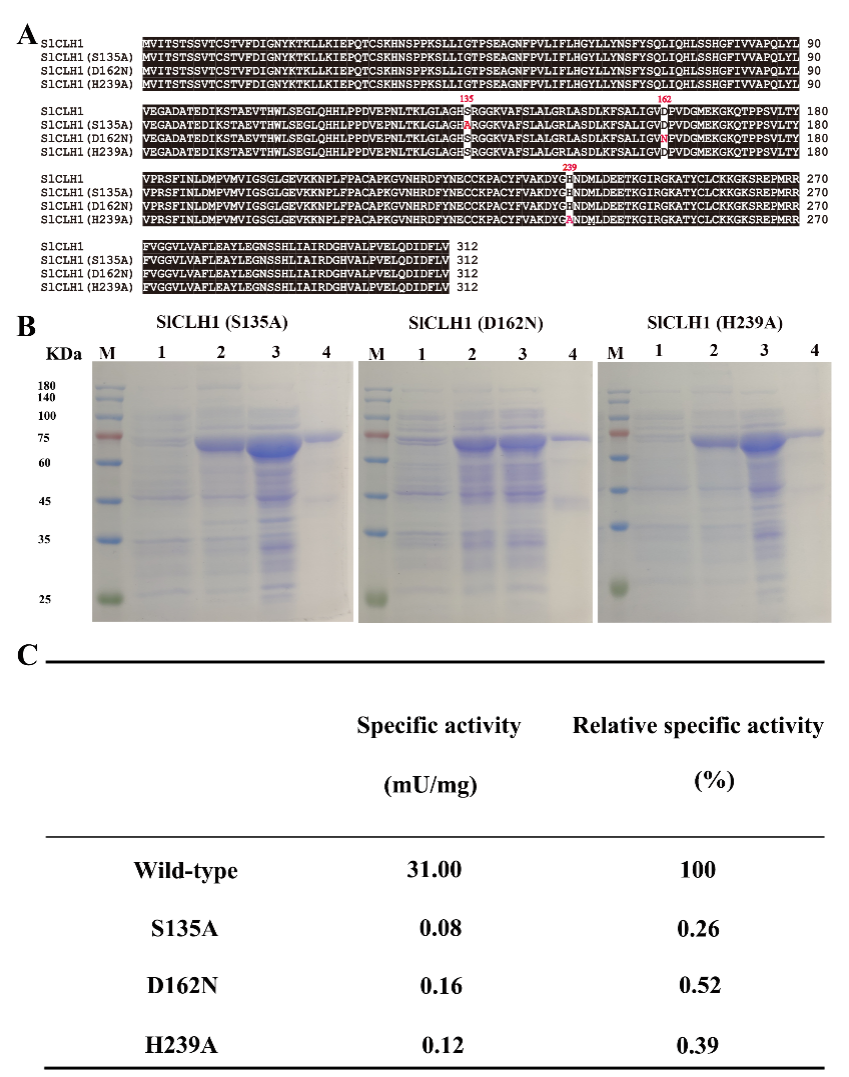
Figure 6. Confirmation of the catalytic triad of SlCLH1 by Site-directed mutation. ( A ) Alignment of amino acid sequences of wild-type SlCLH1 and the generated SlCLH1 sequences with site-directed mutation at the catalytic triad. Three mutated SlCLH1 were generated with one amino acid mutation of the catalytic triad residues for each. Site-directed mutagenesis introduced in three mutated SlCLHs are shown in red. ( B ) SDS-PAGE analysis of N-terminally MBP-tagged recombinant mutant SlCLH1. M, prestained molecular weight marker. Line 1, crude extract of recombinant SlCLHs. Lane 2, purified recombinant SlCLHs after amylose resin affinity column chromatography. The protein gel was stained with Coomassie Brilliant Blue. ( C ) Specific activities and relative activities of purified wild-type and mutated SlCLH1. The relative specific activity of wild-type SlCLH1 was deemed to be 100%. The specific activity of the enzyme was defined as the enzyme activity (units) per milligram of protein.